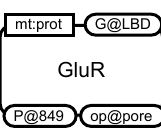
Figure 2.18: An example of a glutamate receptor in the open state.